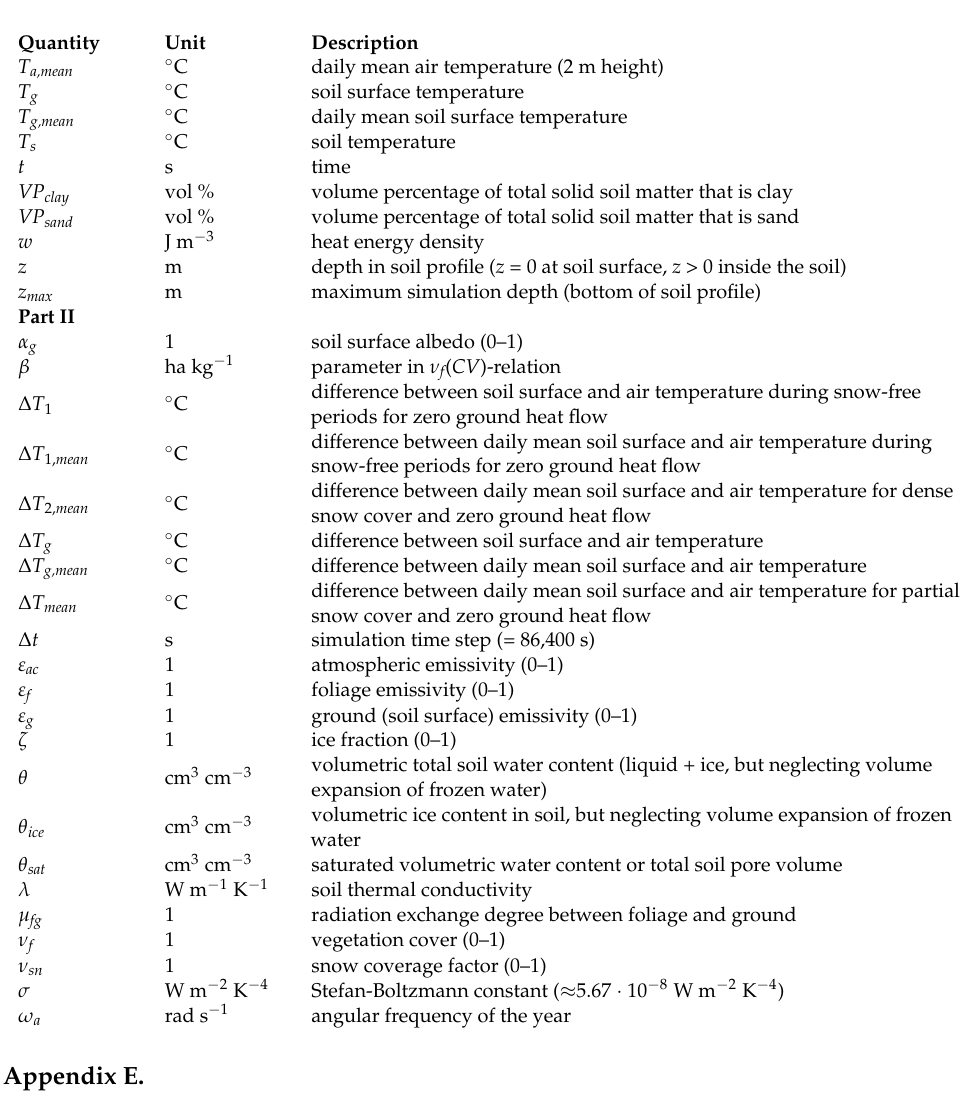
Table A1. Description of nine validation sites in the Czech Republic (related to Figures